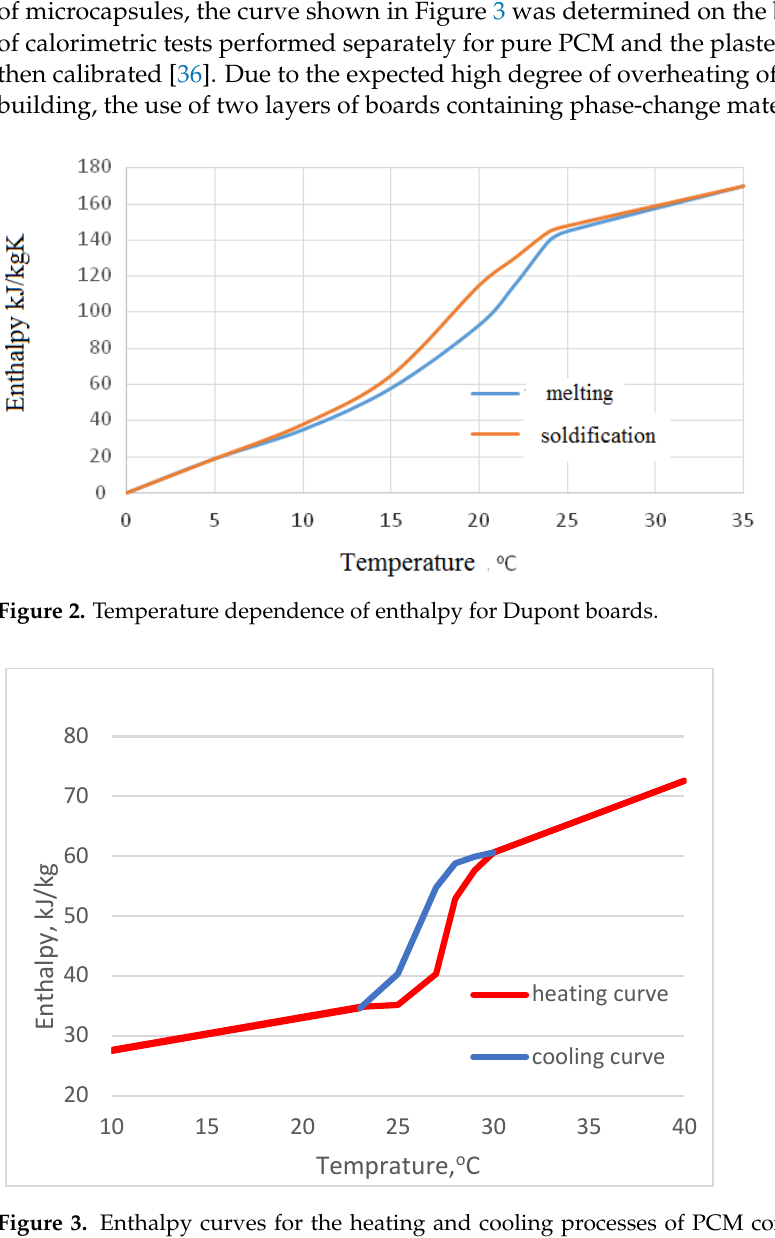
Figure 3. Enthalpy curves for the heating and cooling processes of PCM contained in a plasterboard [2].